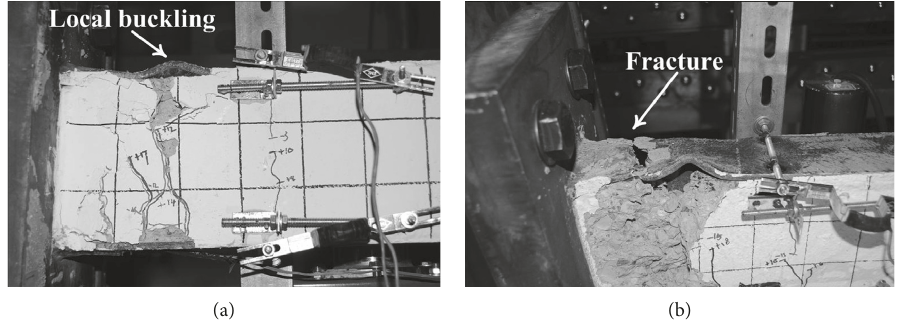
Figure 17: Damage of selected PS specimens. (a) Local buckling of the steel. (b) Fracture of the steel flange of specimen PS-NB.